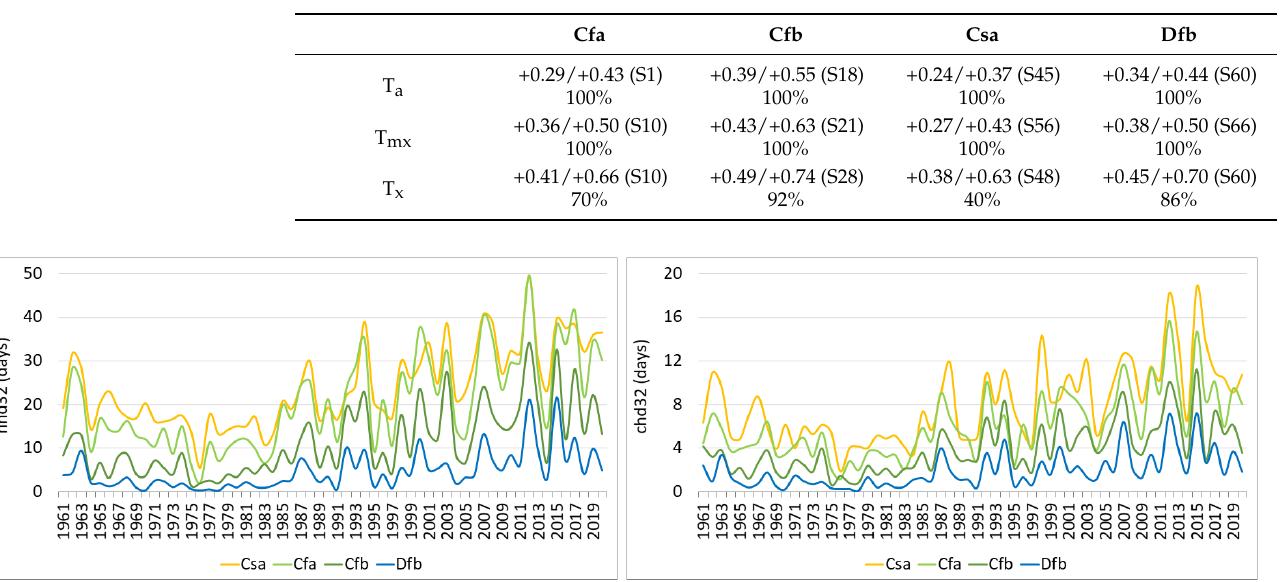
Figure 3. Long-term variations of nhd32 ( left ) and chd32 ( right ) indicators averaged by Köppen– Geiger climate classification